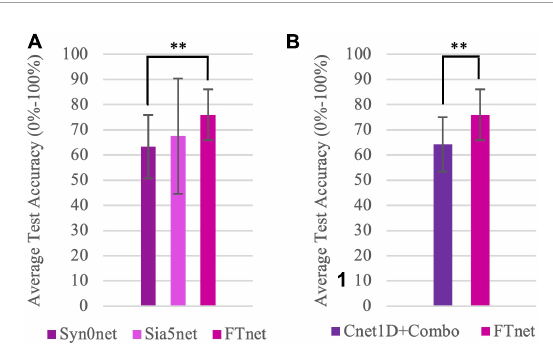
FIGURE7 Task-Transfer Experiments results. (A) Comparison of classification accuracy of combined movements database including 6 movement classes (Chance level = 16.67%) averaged over all Nearlab subjects using the three stages of task-transfer analysis. Syn0net leverages the synergies found in basic movements utilizing no samples from target domain. Sia5net, a few-shot learning method, uses 5 query samples of each class of target domain. FTnet, employs fine-tuning method with few seconds of target domain data. (B) Comparison of classification accuracy of Cnet1D network trained only on combined movements dataset (Cnet1D + Combo) and FTnet framework which leverages the information learned from basic hand movements (source domain), when tested on combined movement dataset (chance level = 16.67%) and averaged over all subjects. This panel highlights the effect of pre-training